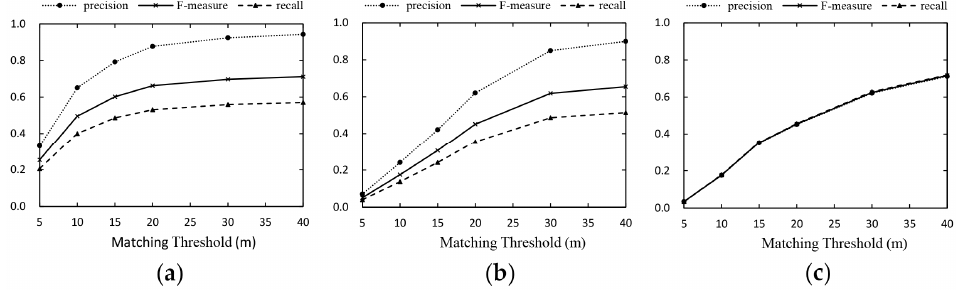
Figure 14. Accuracy analysis of intersections from the Chengdu dataset. ( a ) Proposed method; ( b ) Davies’s method; and ( c ) Ahmed’s method. Because of the small difference between the number of extracted intersections and real intersections, the precision, recall and F-measure nearly overlap.